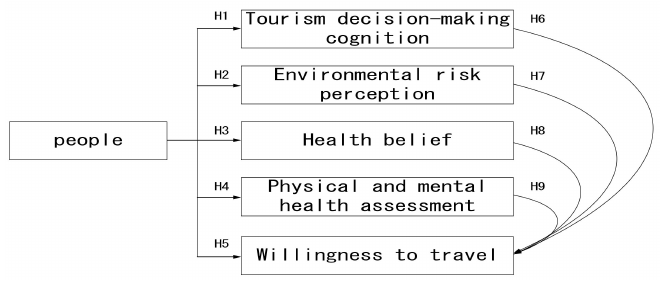
Figure 1. The research